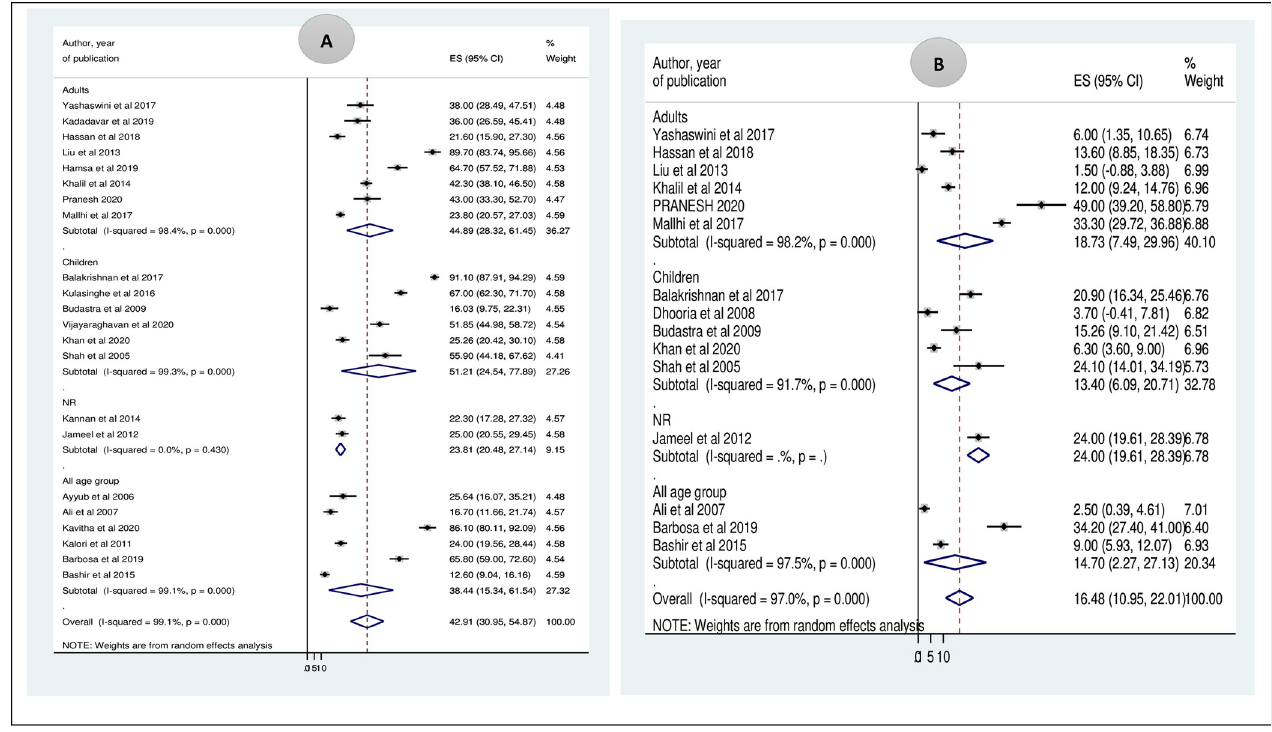
Fig 4. A Sub-group analysis of prolonged APTT based on age distribution B. Sub-group analysis of prolonged PT based on age distribution.